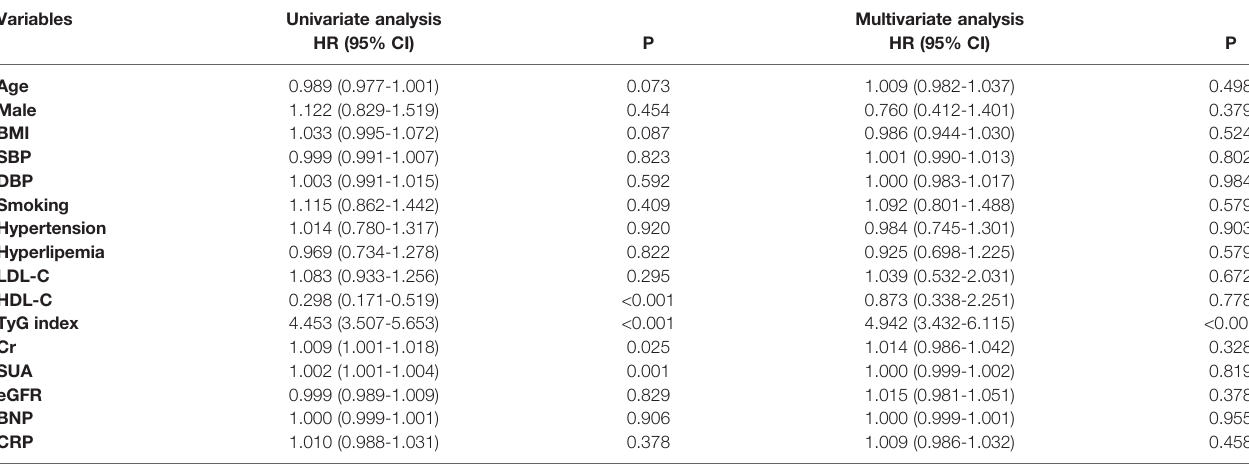
TABLE 3 | Independent predictors of MACCEs in overall patients. Variables